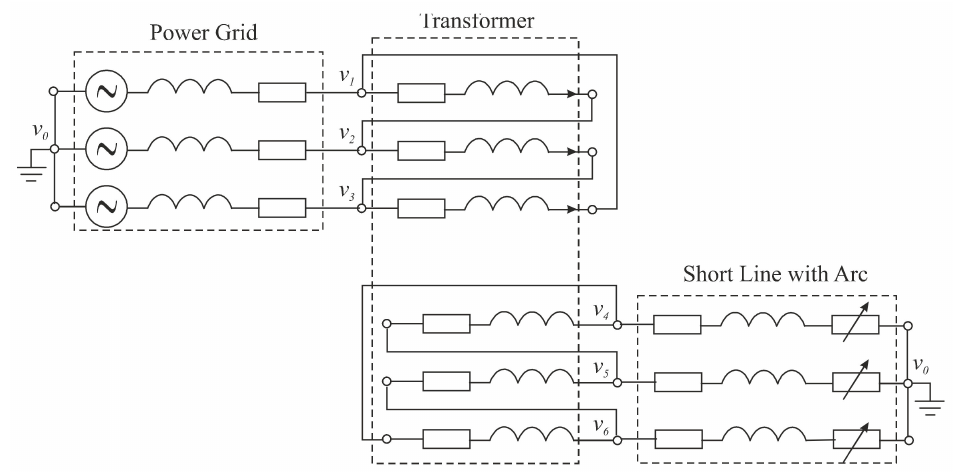
Figure 9. Calculation scheme of arc power supply